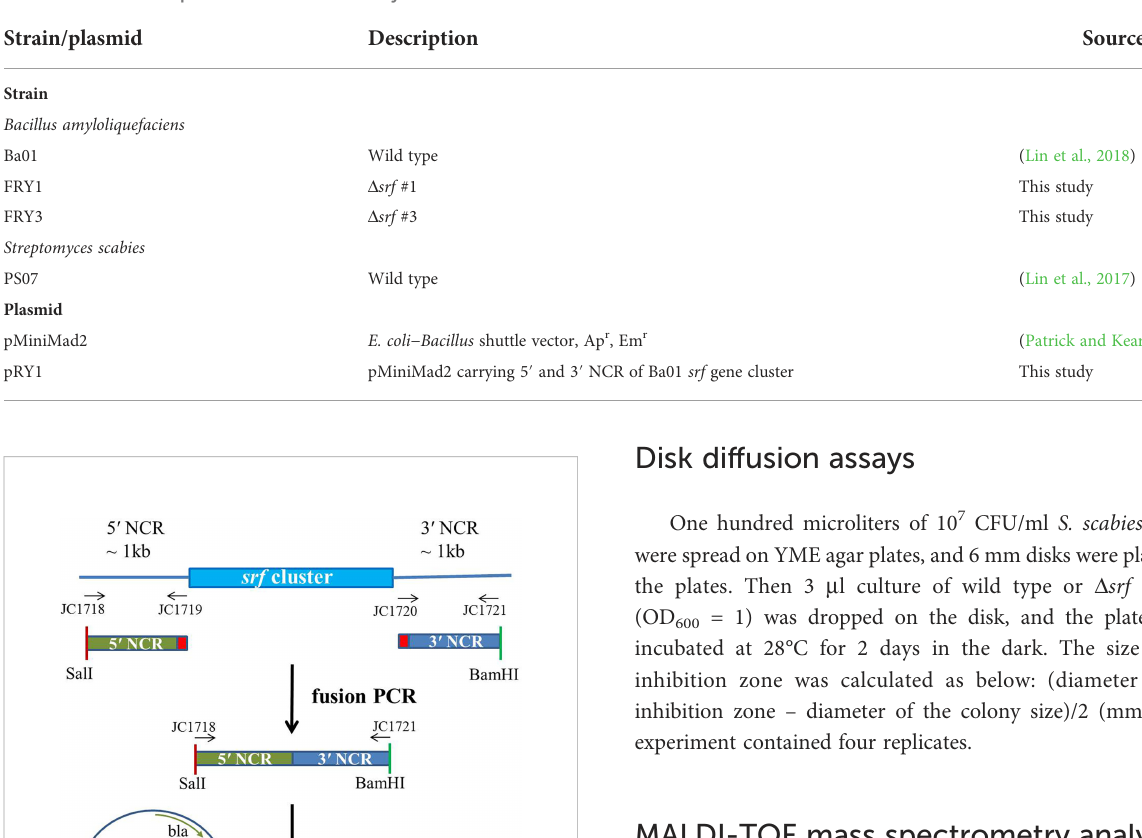
TABLE 1 Strains and plasmids used in this study.